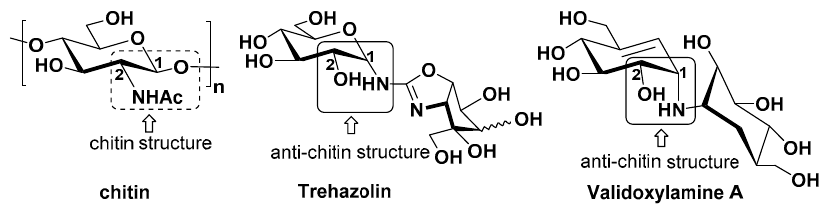
Figure 2. The “anti-chitin structure” of some natural CSIs.